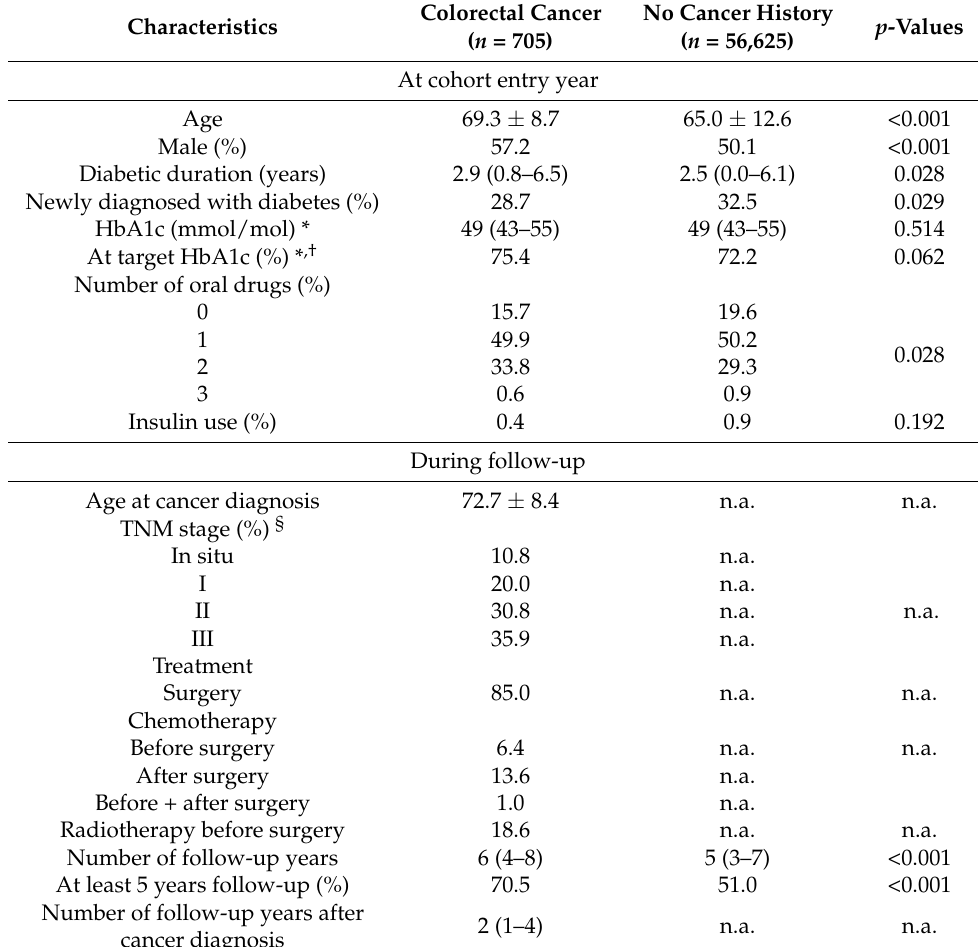
Table 1. Characteristics of patients with type 2 diabetes—diagnosed with colorectal cancer versus no history of